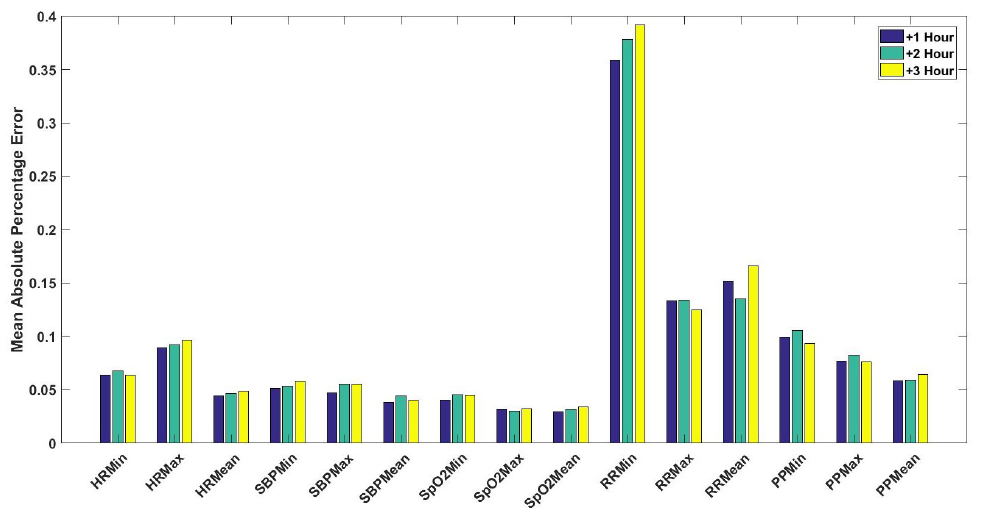
Figure 6. The mean absolute percentage error (MAPE) of the predicted statistical values (i.e., minimum, maximum, and mean) for the vital signs of HR, SBP, Sp O 2 , RR, and PP for the upcoming one, two, and three hours ( + 1, + 2, + 3 h) for cardiology patients.